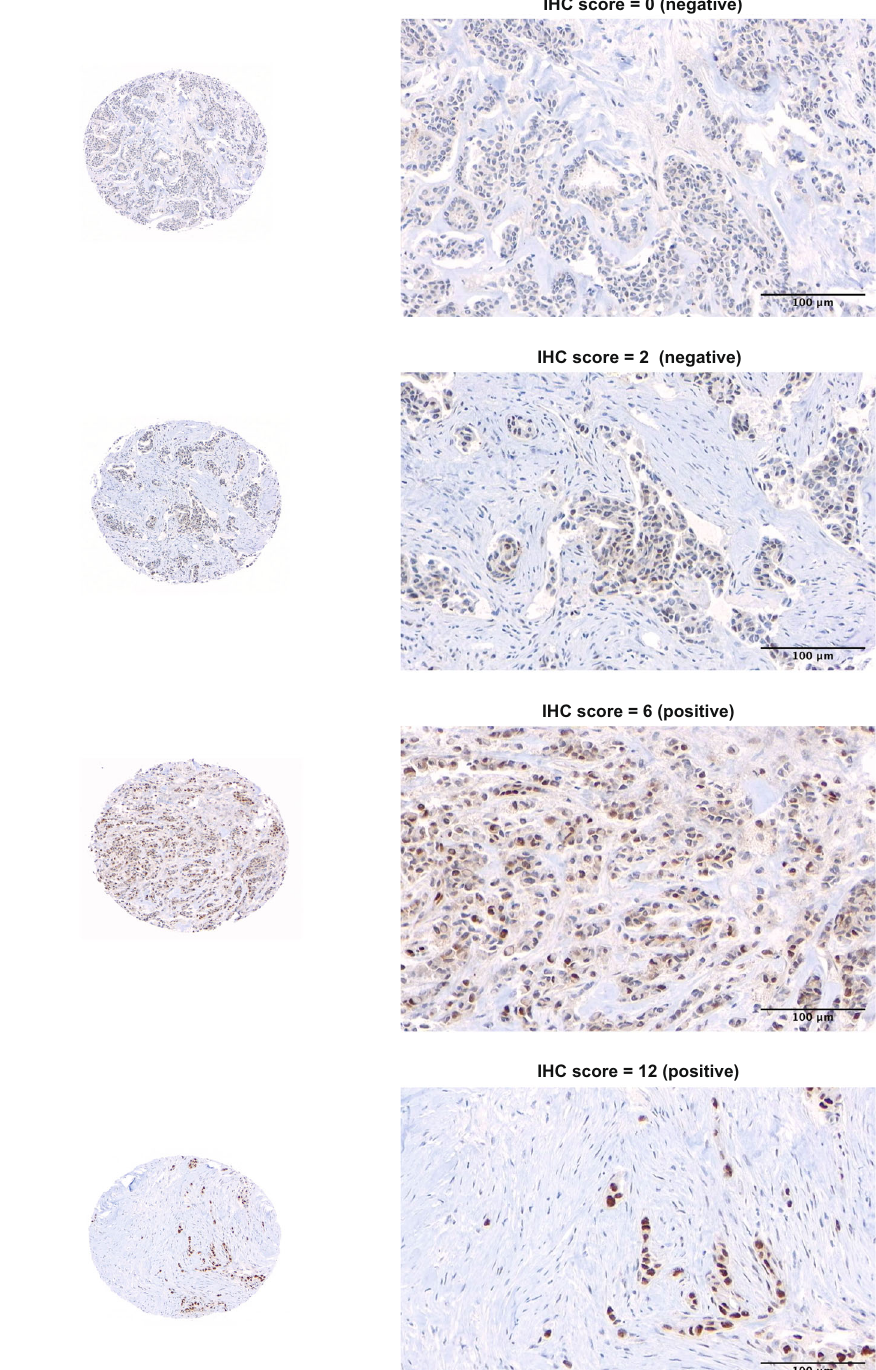
Fig. 1 Representative images for nuclear expression of DNA-PKcs by immunohistochemistry. A case with negative staining for DNA-PKcs (IHC score = 0) is shown in ( a ), a case with 10% positivity and weak intensity (IHC score = 2) is shown in ( b ), a case with 40% positivity and moderate intensity (IHC score = 6) is shown in ( c ), and a case with 90% positivity and strong intensity (IHC score = 12) is shown in ( d ). The images were acquired at 20× objective magni fi cation (200× original magni fi cation) for the tissue microarray cores. Scale bar of 100 µm is shown. Abbreviations: IHC, signi fi cantly associated with basal-like PAM50 subtype and ER for DNA-PKcs expression when compared to the other negativity (Fig. 6b, c). In addition, high PRKDC expression is also PAM50 subtypes ( p -value<0.001) (Fig. 5). associated with basal-like gene signature within ER + tumors in We next assessed the expression of the DNA-PKcs gene ( PRKDC ) at the transcriptomic level using data from the TCGA invasive the TCGA cohort (Supplementary Fig. 3). We further validated the association between PRKDC expression and the basal-like breast cancer cohort 8 (Fig. 6a). Higher PRKDC expression is